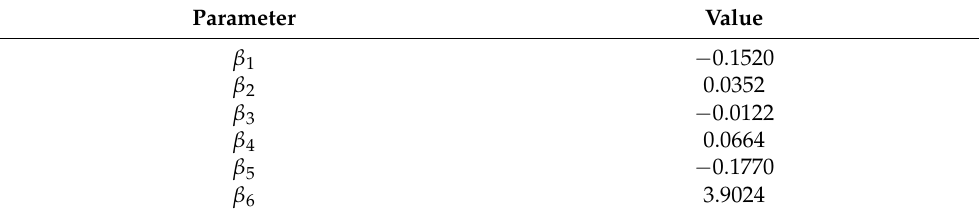
Table 2. Deterministic parameters calculated with daily prices.